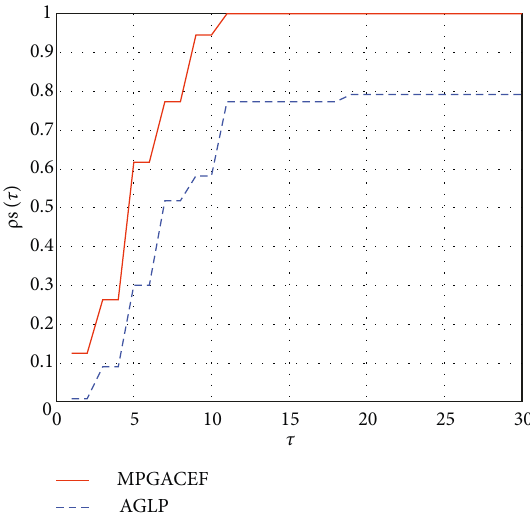
Figure 7: Performance of NIT Time for MPGACEF and AGLP under the condition of CVRP50.